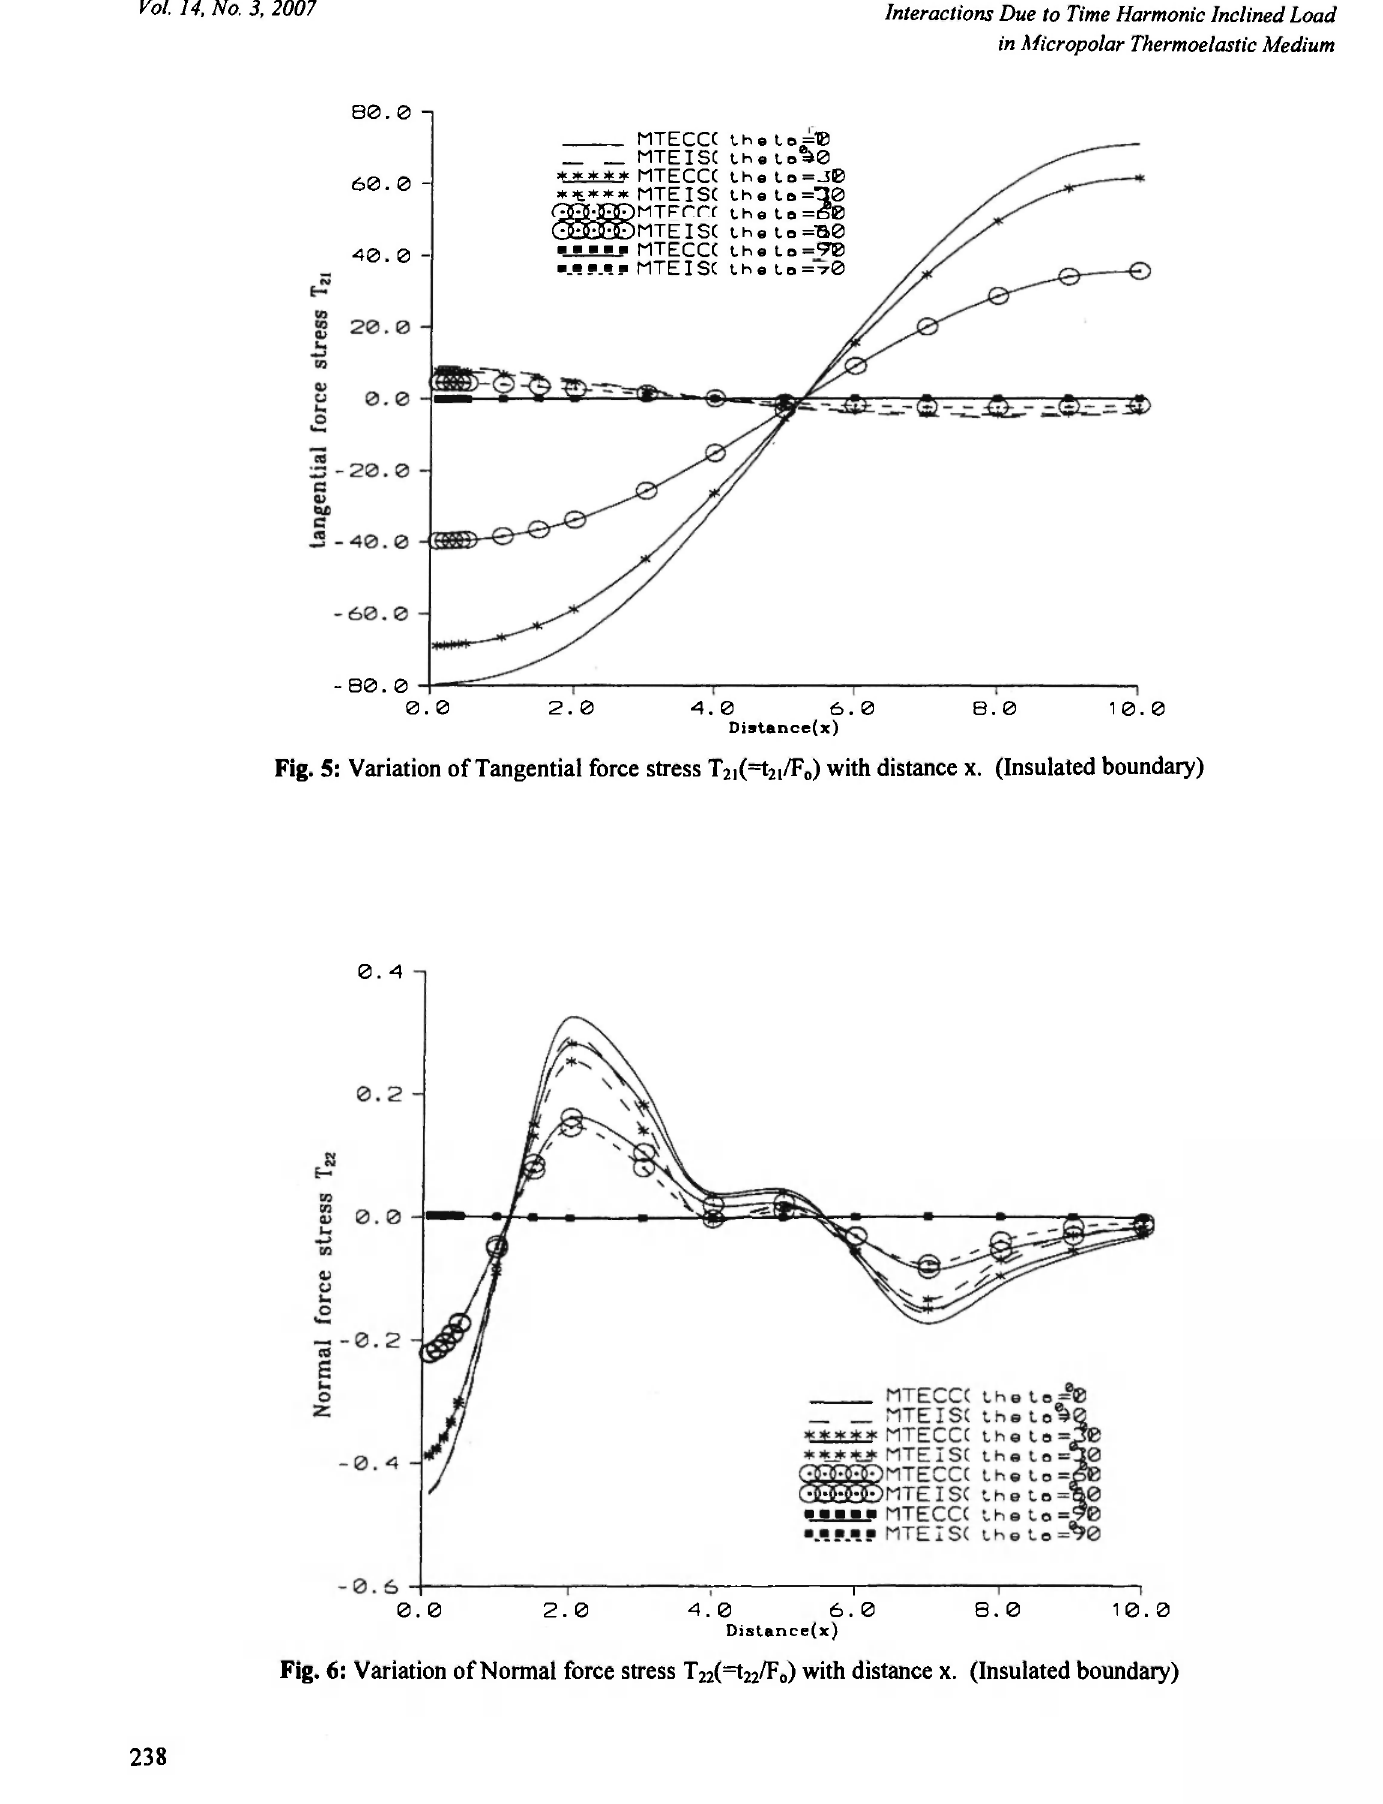
Fig. 6: Variation of Normal force stress T 2 2( = t22/Fo) with distance x. (Insulated